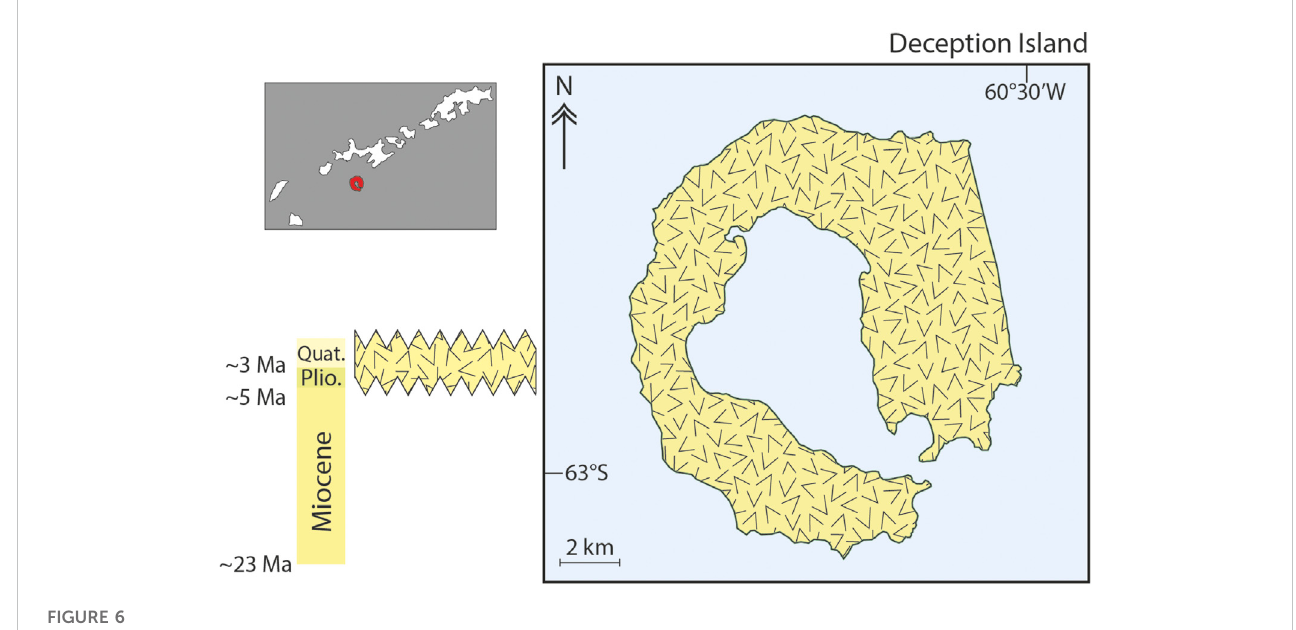
FIGURE 6 Geological map of Deception Island.